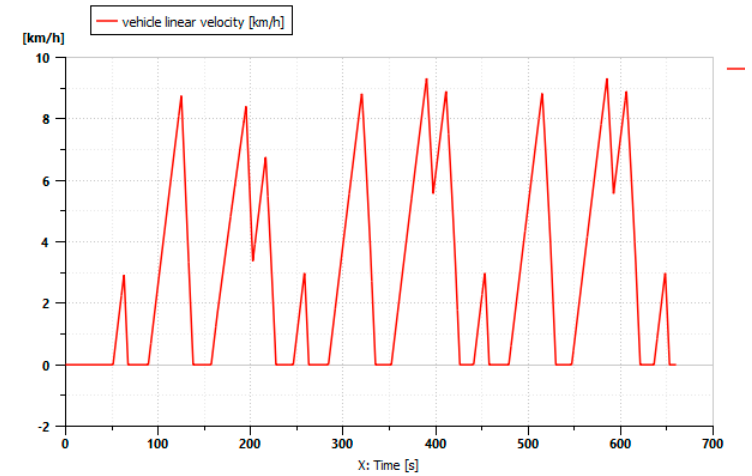
Figure 17. Tractor driving cycle with a Bette Harvest attached.